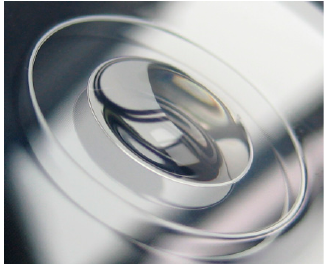
Figure 7. Precision-molded rear window of the demonstrator with its integrated optics (optical aperture of 6 mm) [1].